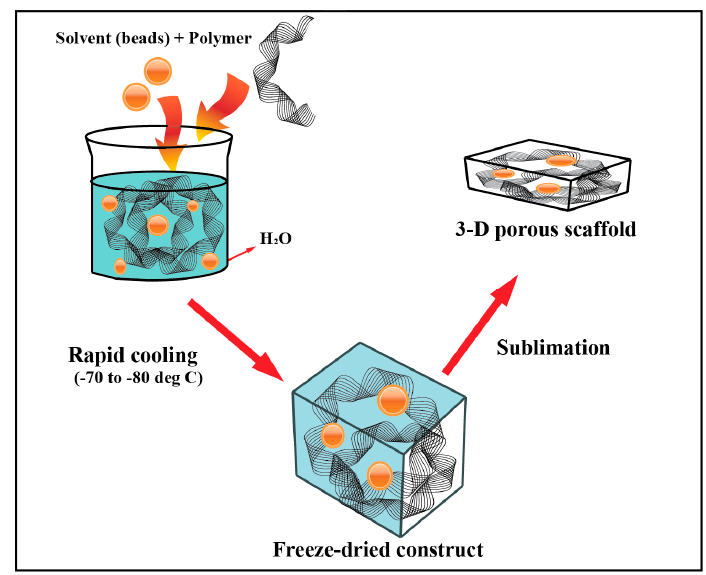
Figure 2. Freeze-drying (lyophilization) technique.